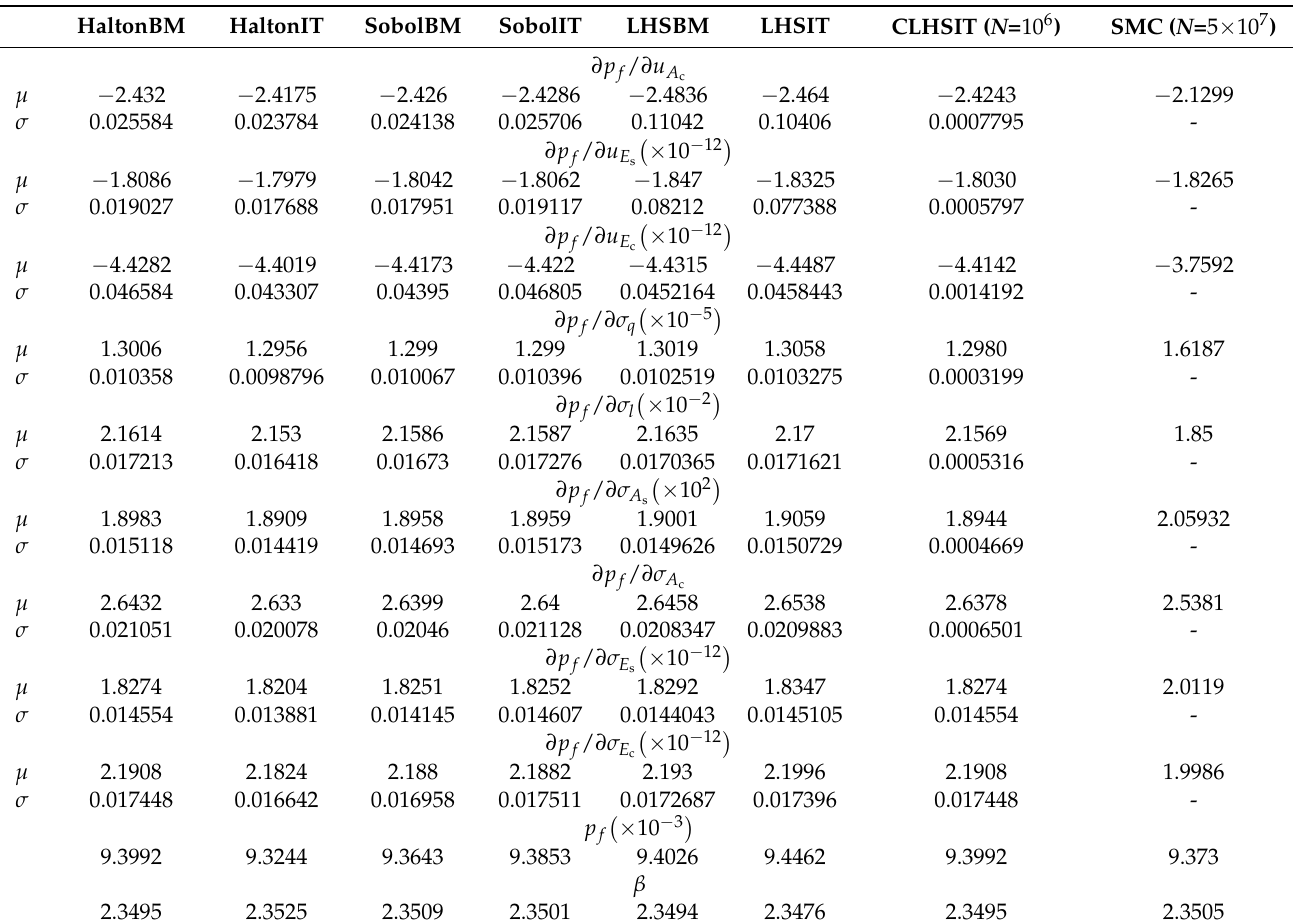
Figure 7. Maximum relative errors of sensitivity and failure probability when 𝑁 = 50 and 1000 in Example 3. ( a ) Maximum relative errors of sensitivity (%); ( b ) Maximum relative errors of failure probability (%)